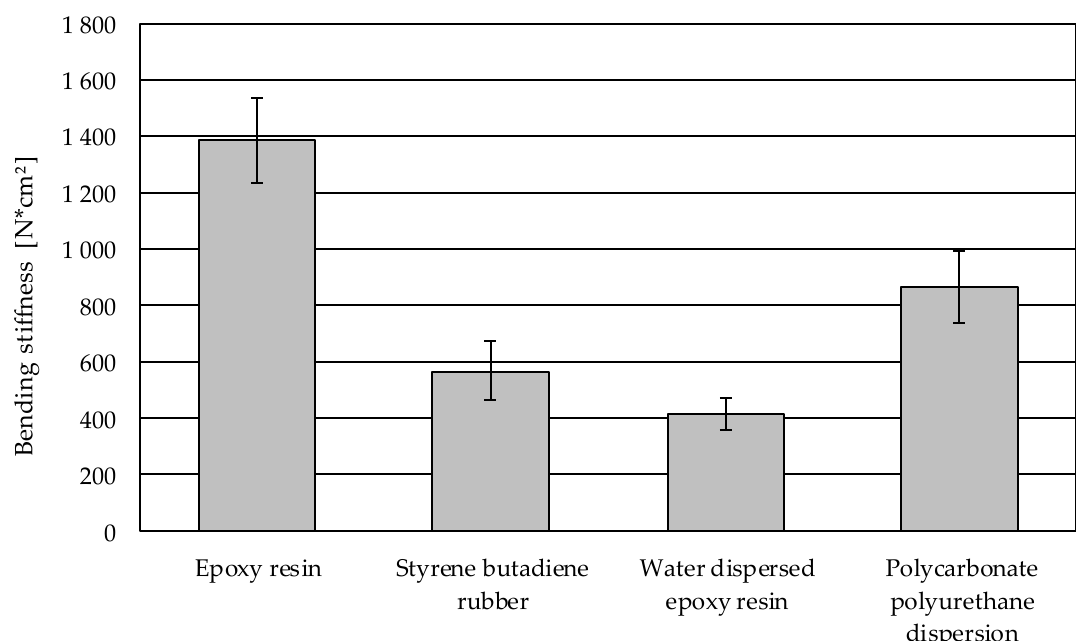
Figure 6. Resulting average bending stiffness of cured impregnated rovings in the cantilever tests (error bars indicate standard deviation).